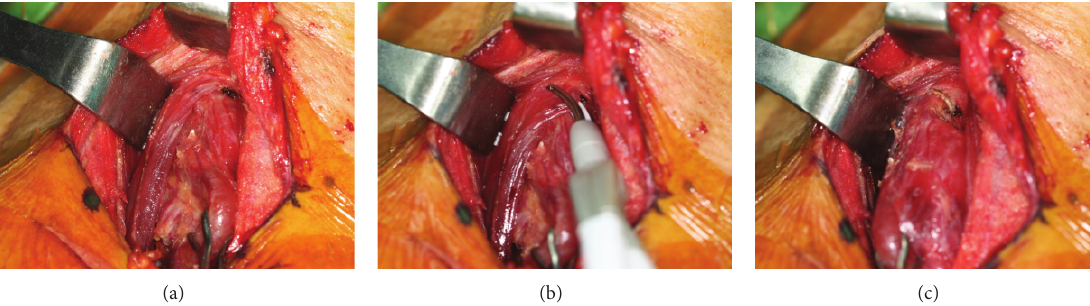
Figure 1: Partial cutting of sternothyroid muscle during thyroidectomy. (a) Superior pole of right thyroid gland covered by sternothyroid muscle. (b) Cutting the medical 2cm of sternothyroid muscle. (c) Good exposure of the superior